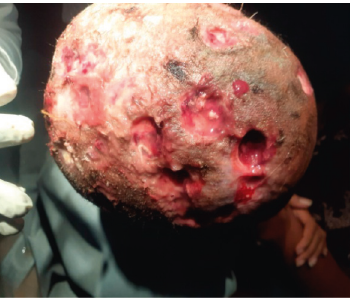
Figure 6: Multiple punched-out scalp lesions and pictures were taken at 12 years and 10 months right after the